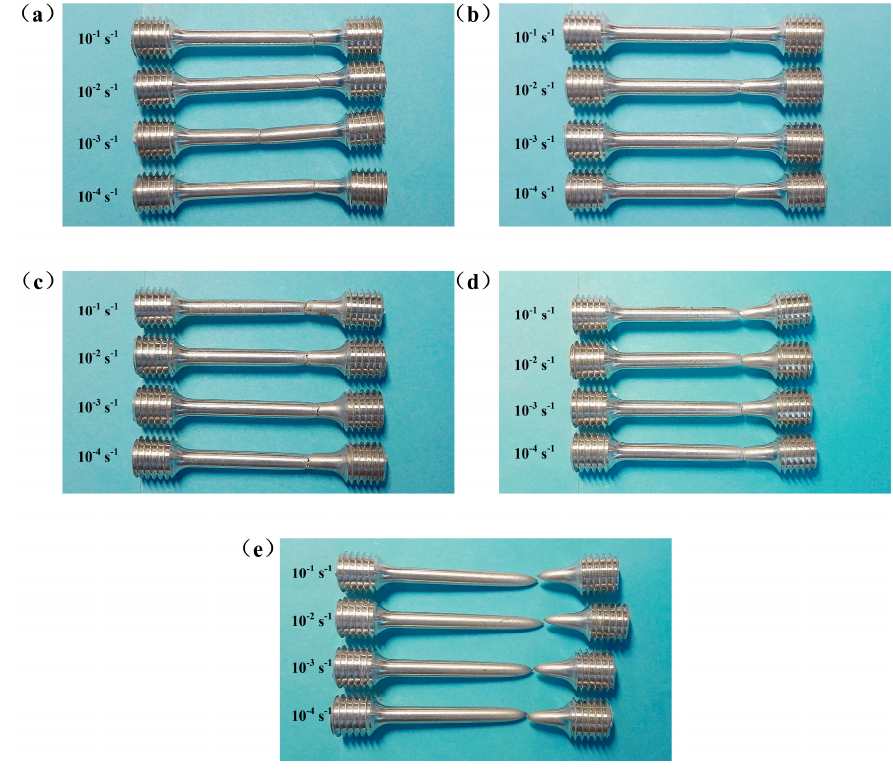
Figure 8. Fracture specimens at temperatures of: ( a ) RT; ( b ) 100 °C; ( c ) 200 °C; ( d ) 300 °C; ( e ) 400 °C.